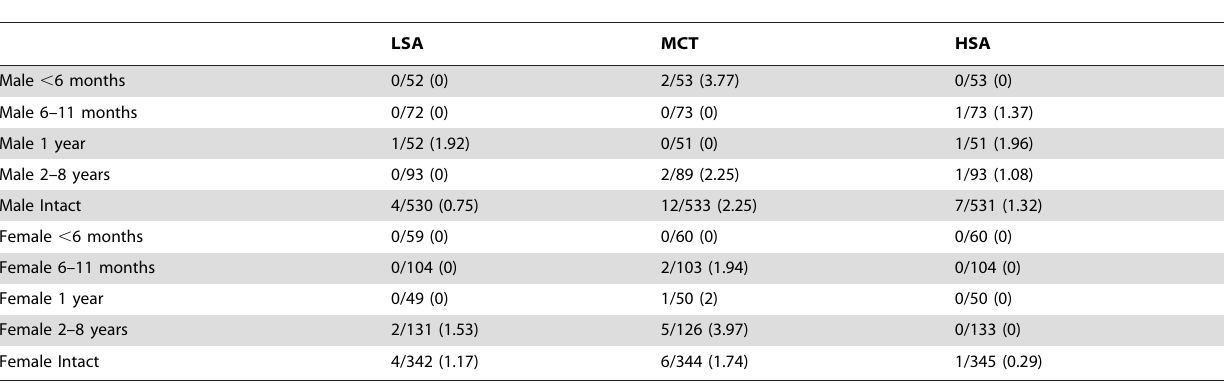
Table 5. Labrador Retriever males and females,